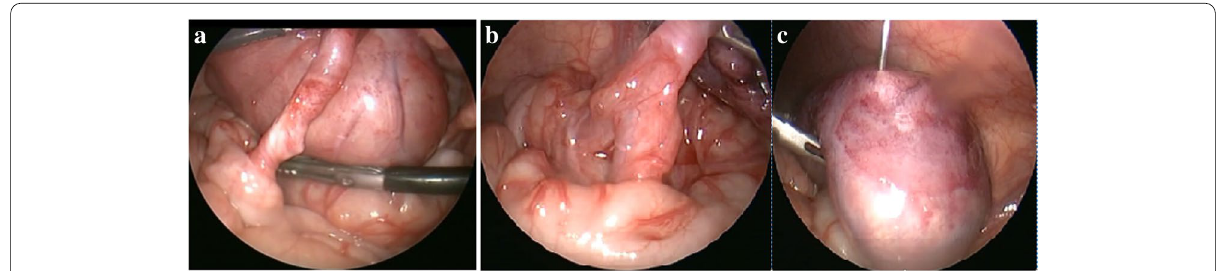
Fig. 2 a Cyst with an isolated peduncle, hanging free on an isolated vascular stalk which emerged from the mesentery of the sigmoid colon (retrocolic), b the structure of the peduncle extending to the sigmoid colon, and c the extracorporeal aspiration of the cyst